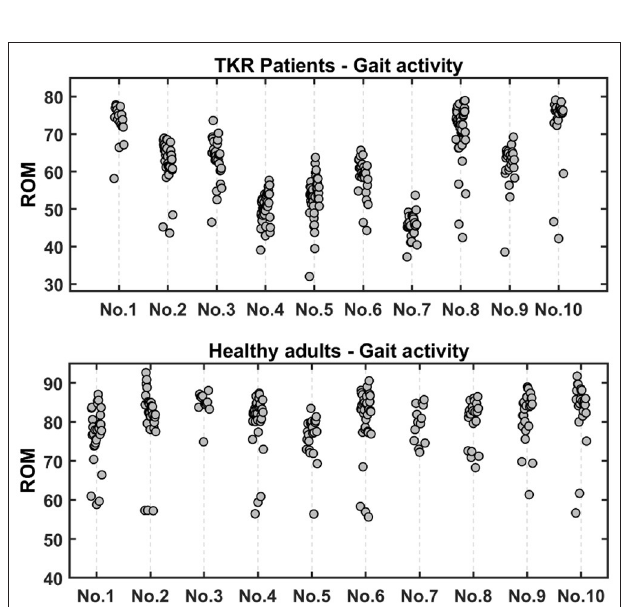
FIGURE 7 | Knee ROM of TKR patients. They are divided into knee replacement and knee without replacement.